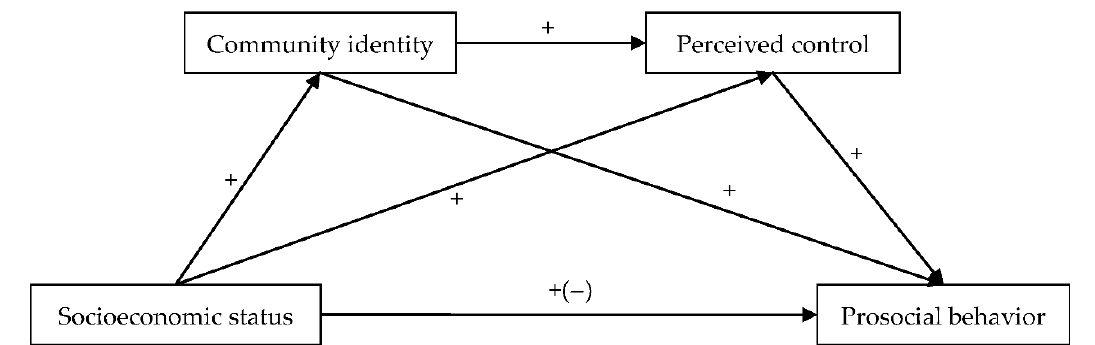
Figure 1. Study model.